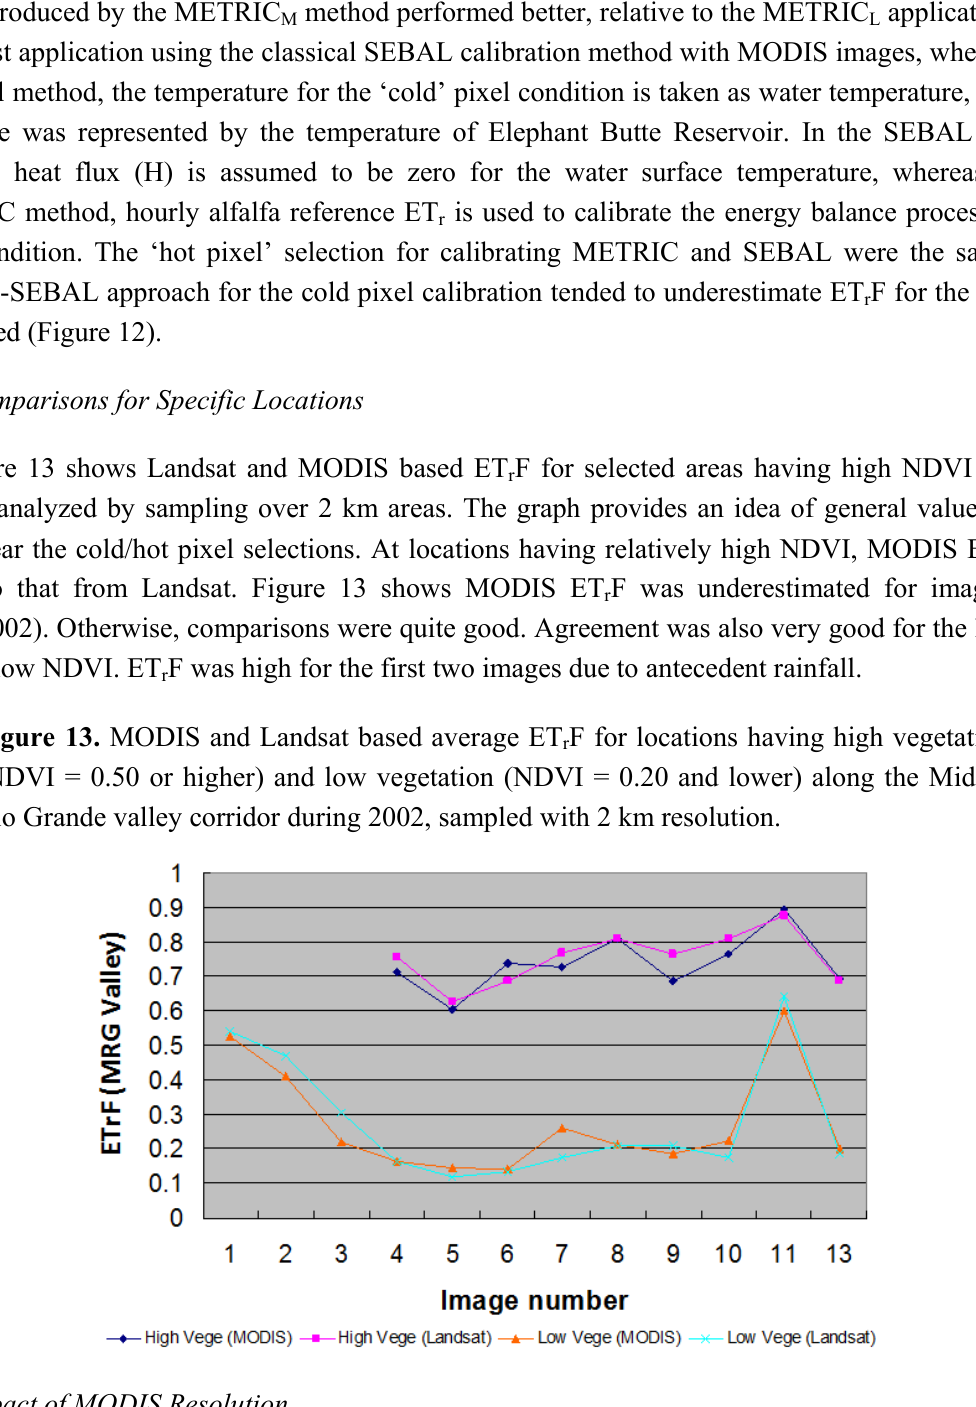
F for locations having high vegetation r